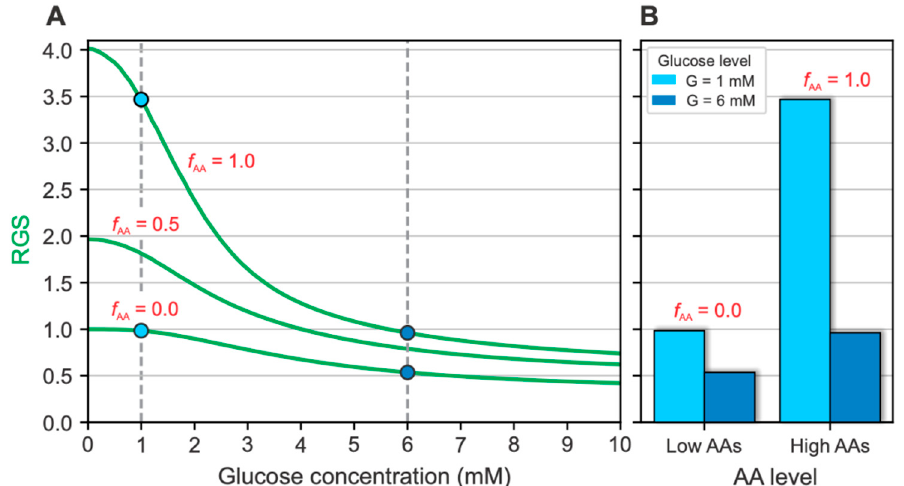
Figure 1. The influence of AAs on the GSGS. ( A ) Glucose-dependent RGS at various relative AA concentration levels. The results are normalized to the RGS at low AA concentration levels. The addition of high AA concentration raises the glucose-dependent RGS curve. ( B ) The comparison of the relative change of RGS at 1 mM and 6 mM glucose concentration during low- and high-AAs levels. The increase is most prominent at 1 mM glucose concentration (light blue bars, up to ~3.5-fold increase). On the other hand, the increase during 6 mM glucose concentration is less pronounced (dark blue bars, ~2-fold increase).